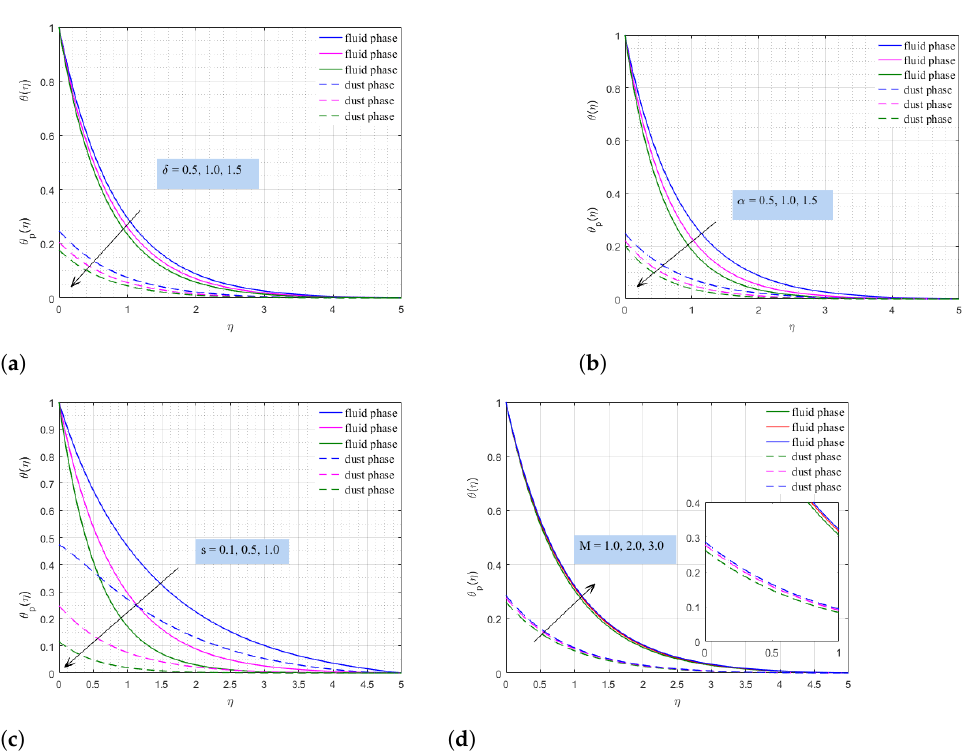
Figure 6. Change in concentration curves for different values of certain parameters. ( a ) Change in temperature profile at different δ values. ( b ) Change in temperature profile at different α values. ( c ) Change in temperature profile at different s values. ( d ) Change in temperature profile at different M values. Table 2. Change in the coefficient of surface friction C f and Nusselt number Nu x at different values x of certain physical